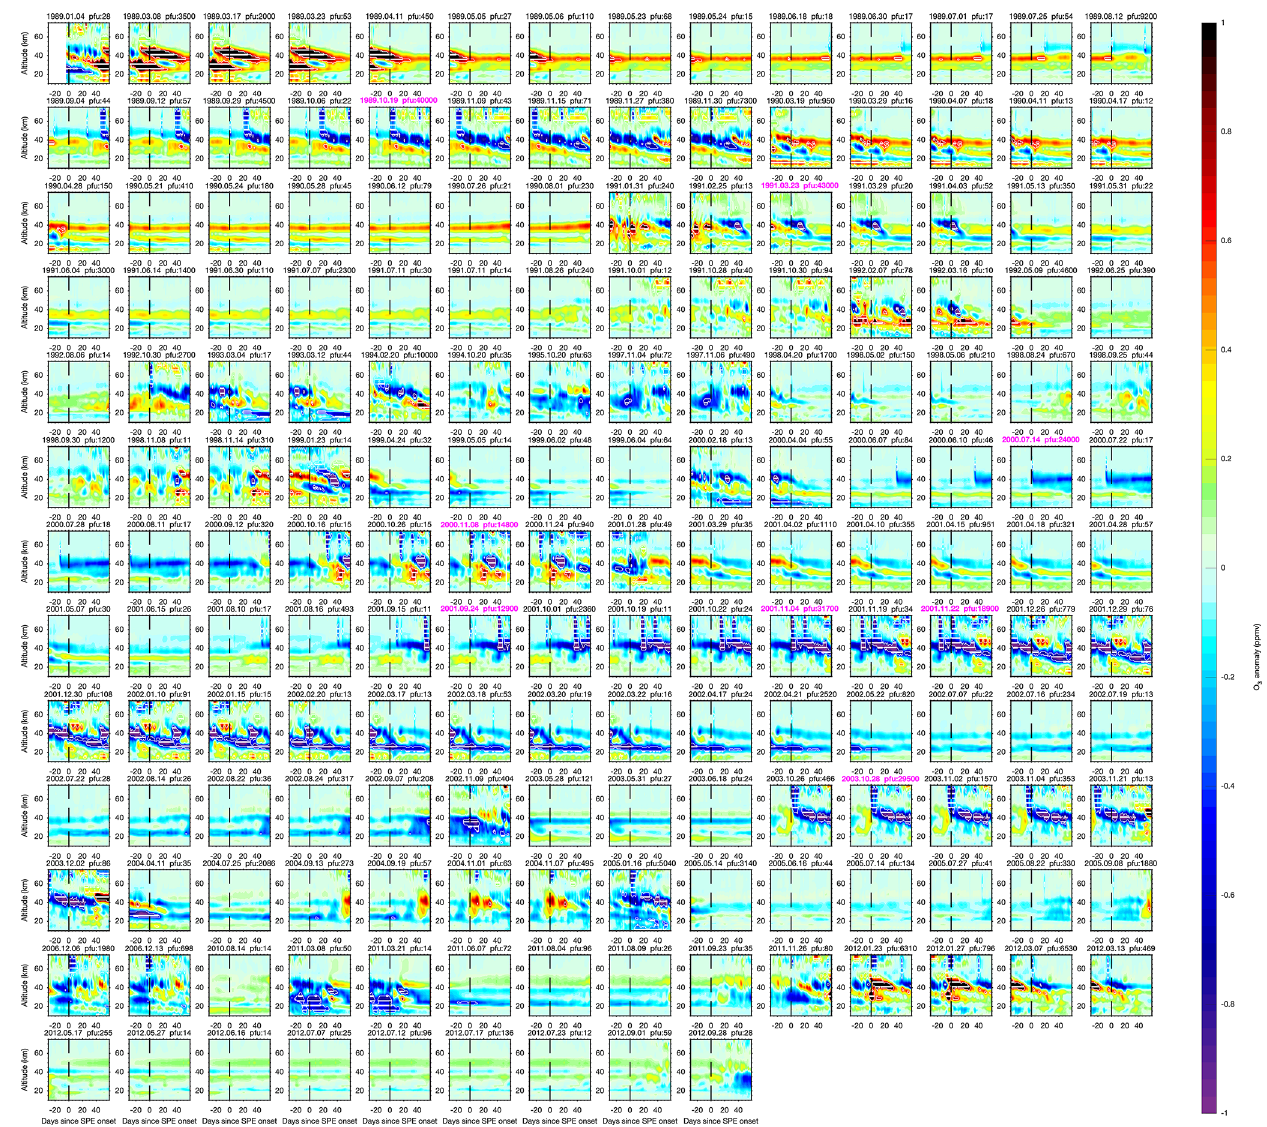
Figure A3. Same as Fig. 4 but after all individual SPEs since